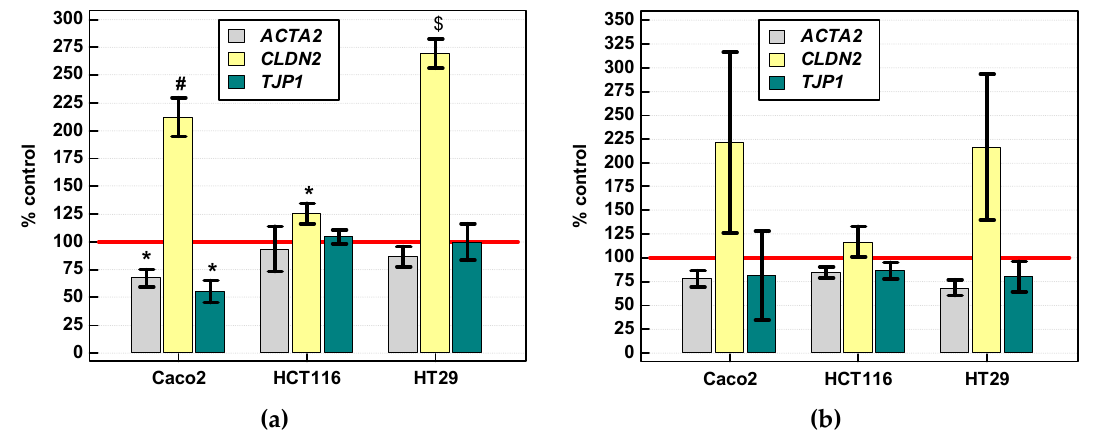
Figure 19. Effect of IL-4 and IL-13 stimulation on the expression of epithelial-mesenchymal transition markers and tight junction proteins: ( a ) 24-hour stimulation with 250 ng/mL of IL-4; ( b ) 24-hour stimulation with 250 ng/mL of IL-13. Bars represent mean ± SE ( n = 4) of relative gene expression in stimulated as compared to unstimulated (controls) cells expressed as a percentage. Reference expression level of untreated cells (100%) is represented by red horizontal line. Statistically significant differences in treated cells as compared to their respective controls, analyzed using t -test for one mean, are marked as follows: p < 0.05 as *; p < 0.01 as #; p < 0.001 as $.